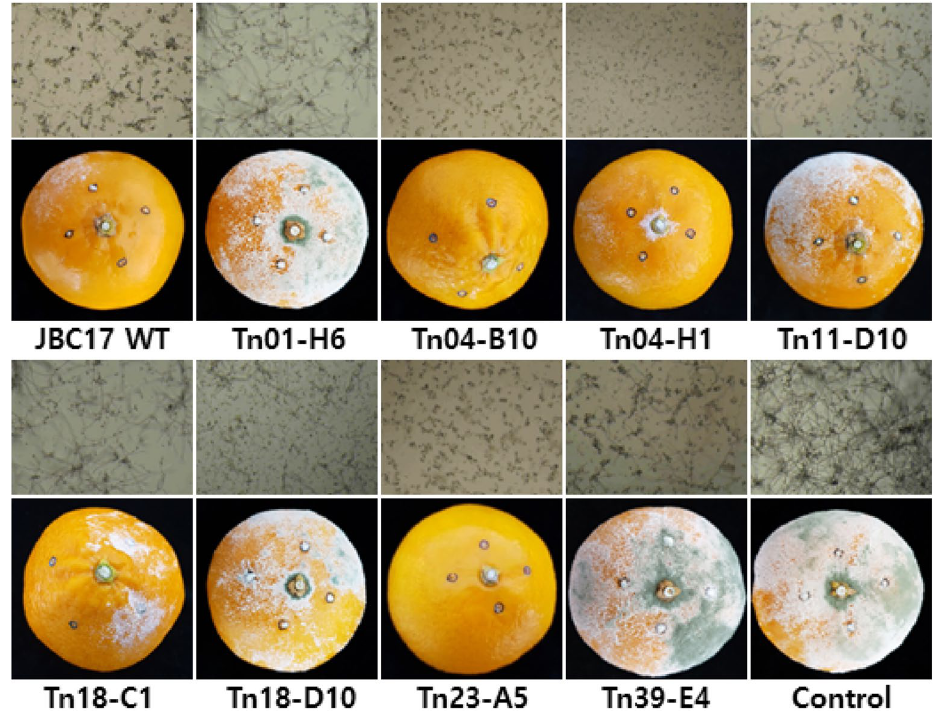
Figure 2. Inhibition of Penicillium digitatum conidial germination and suppression of green mold of mandarins by treatment with Pseudomonas putida JBC17. For the conidial germination assay, conidia of P. digitatum were incubated in 10% PDB with cells of P. putida JBC17WT or each mutant and were separated by a PTFE membrane. The conidial germination was photographed with a microscope after 24 h incubation at 25 °C (top panel). For the biocontrol assay, mandarin fruits inoculated with P. digitatum (10 6 conidia/ml) were treated with bacterial suspensions (1 × 10 8 cfu/ml) and then incubated at 20 °C and 90% relative humidity for 7 d (bottom panel). The figure shows representative mutants with altered activity in the inhibition of conidial germination and disease development compared to the wild